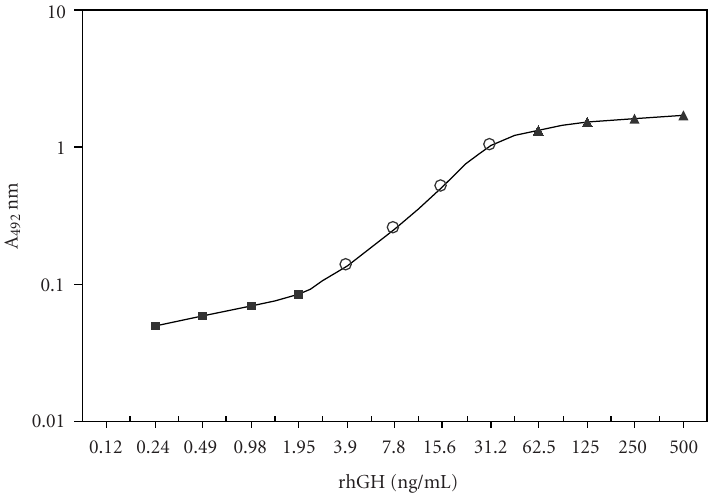
Figure 1. Saturation curve for rhGH. The working range was ( (cid:3) ) from 1.95 to 31.25 ng/mL. A trend to linearity can be observed at the interval between 0.24 to 1.95 ng/mL ( (cid:1) ). A trend to a plateau ( (cid:1) ) can be found at high rhGH concentration.